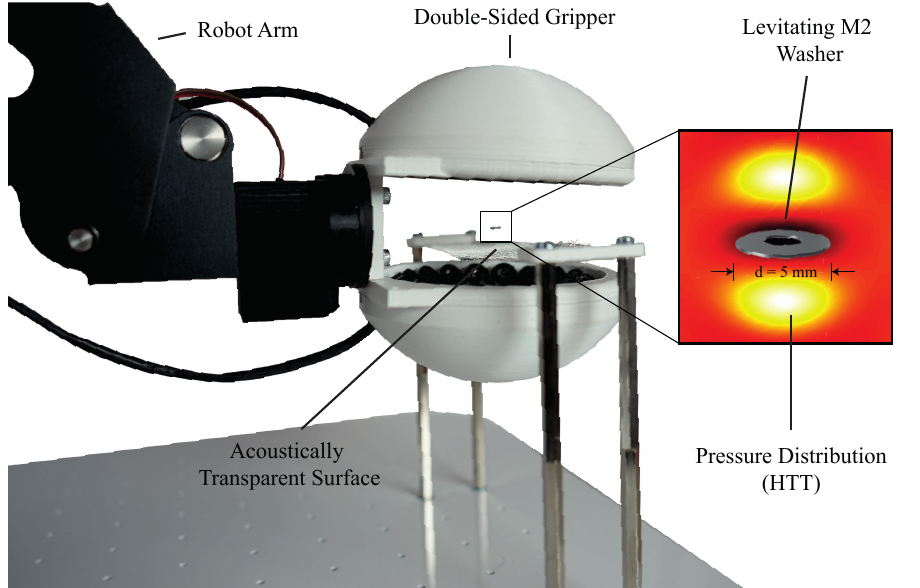
Figure 1. Double-sided gripper arrangement capable of picking objects with a density of >7 g/cm 3 from acoustically transparent surfaces using a horizontal twin trap (HTT). The system is mounted to a robot arm for long-range movements.